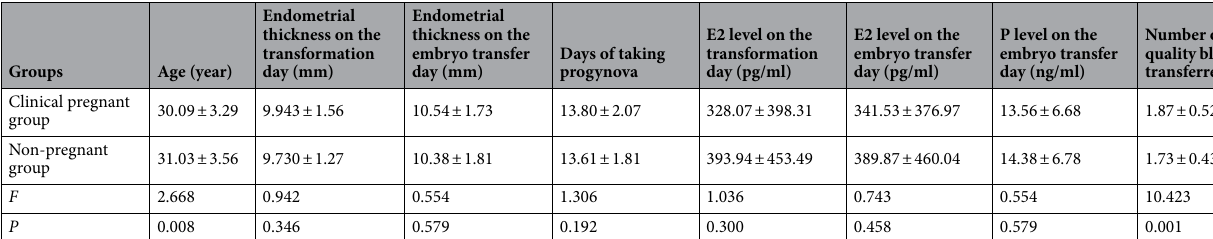
Table 5. Comparisons of clinical characteristics and hormone levels between pregnant group and non- pregnant